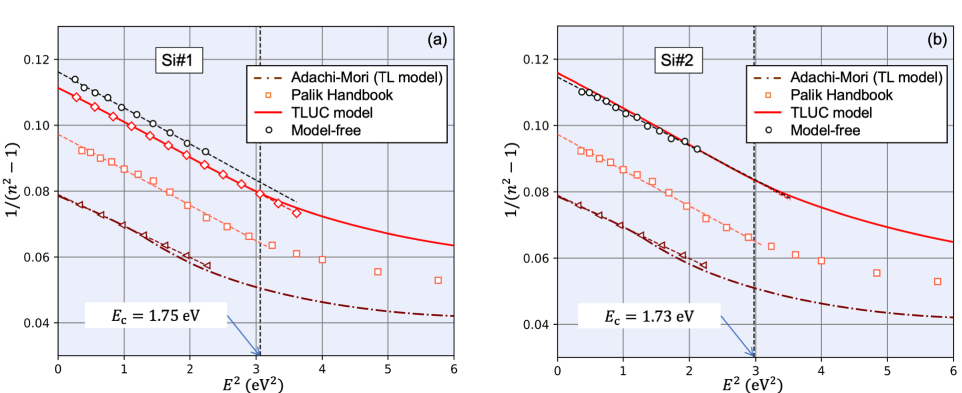
Figure 6. Plot of the refractive-index factor, 1/ ( n 2 − 1 ) , versus the incident photon-energy squared (i.e., the so-called WDD plot), corresponding to the two example specimens of RFMS- a -Si under analysis; ( a ) Si#1 and ( b ) Si#2.